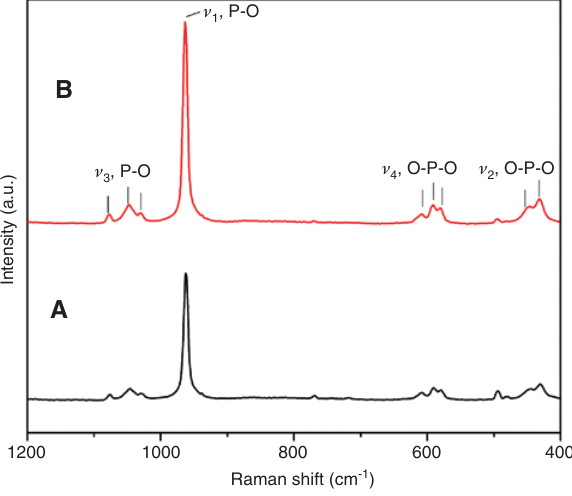
Figure 6: Raman spectra of phase-pure hydroxyapatite nanorods of sample 1, synthesized by using diammonium hydrogen phosphate and calcium nitrate precursors (A) and sample 2, synthesized using calcium hydroxide and orthophosphoric acid precursors (B) via co- precipitation method.